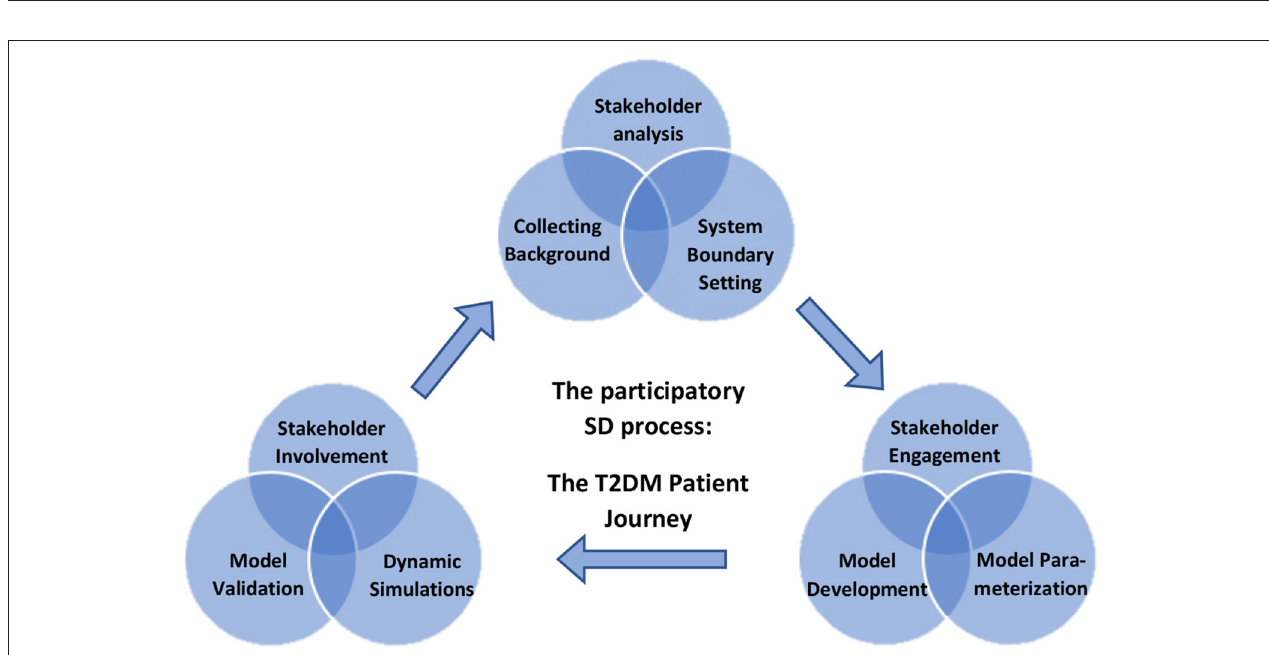
FIGURE 2 | Overview of the participatory process of building a system dynamic (SD) model for decision-making on designing lifestyle programs to reduce type 2 diabetes on Dutch population level using dynamic